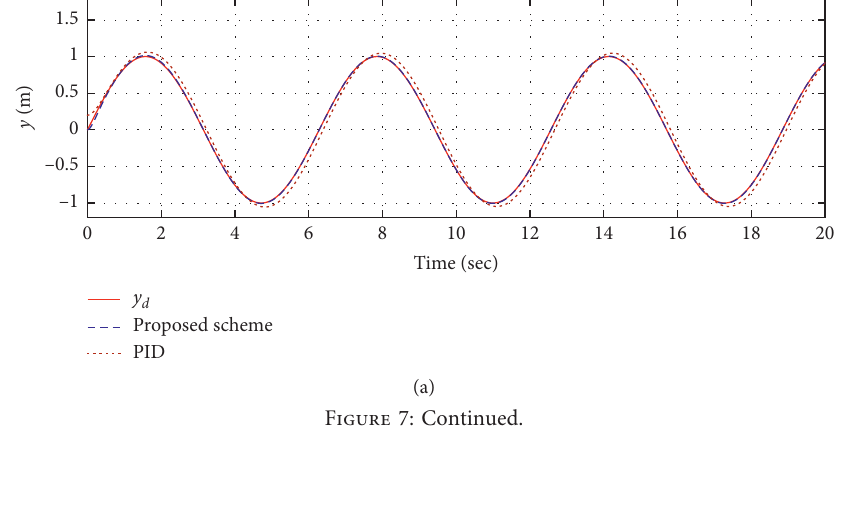
x , and the tracking d ,